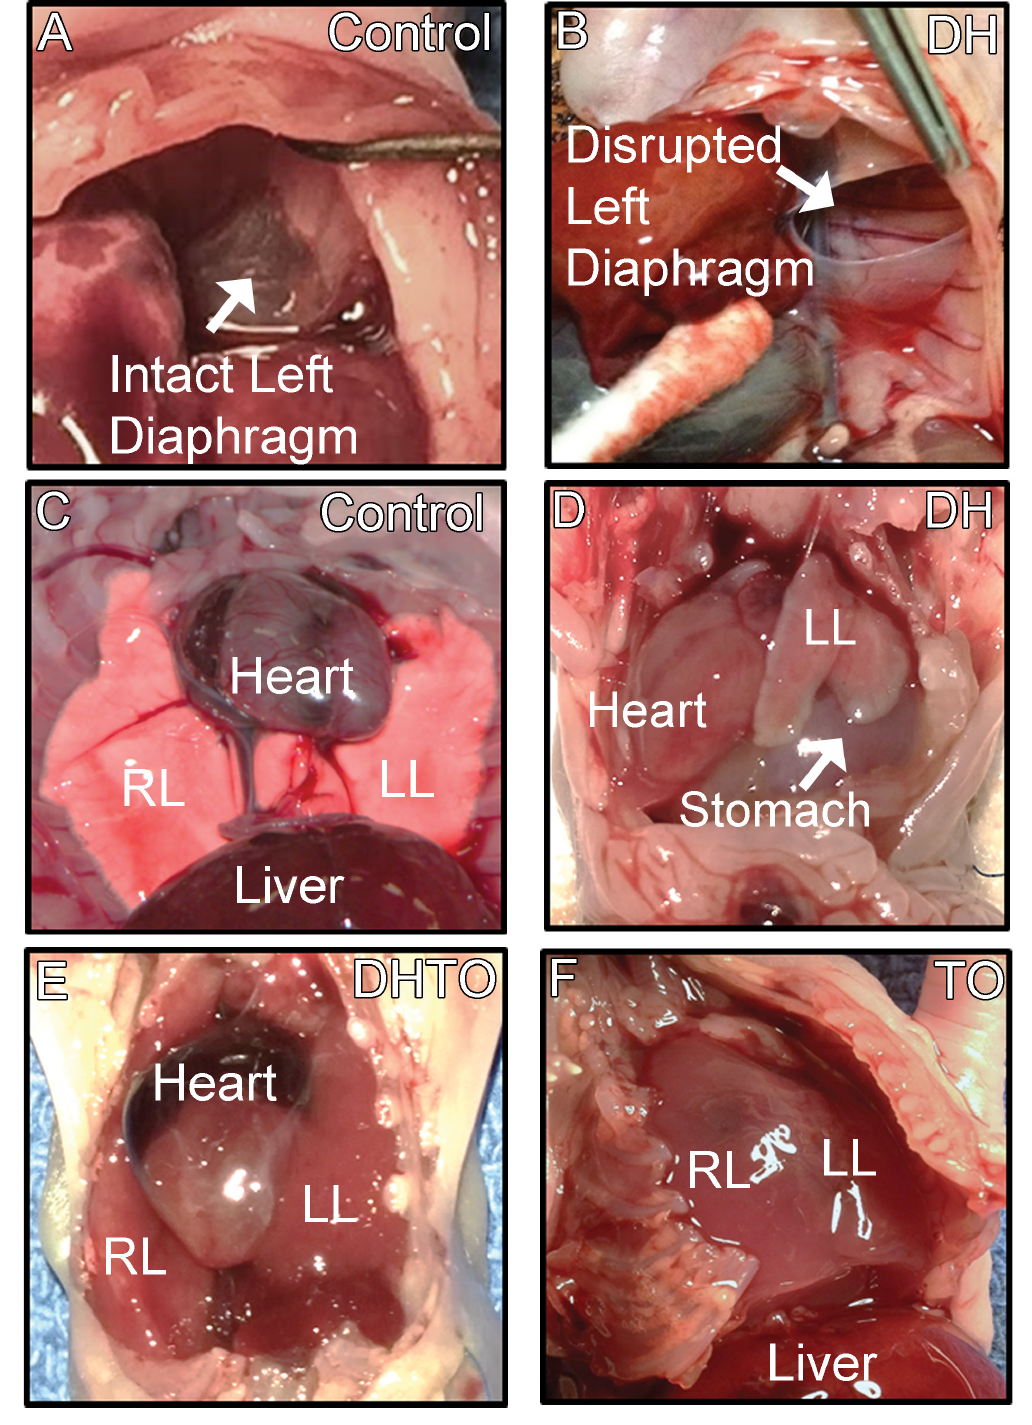
Figure 2. Surgical Model of CDH and CDH/TO. (A) The intact left diaphragm of an E30.5 rabbit fetus. (B) The disrupted left diaphragm of a diaphragmatic hernia (DH) fetus. (C) Normal size of the right lung (RL) and left lung (LL) in a control E30.5 rabbit fetus. (D) Herniation of abdominal contents into the left chest in DH resulted in lung hypoplasia and displacement of thoracic organs to the right. (E) Tracheal occlusion (TO) after DH increased lung size, resolved the rightward shift and reduced herniation of abdominal contents into the thorax. (G) TO alone increased lung size beyond that of